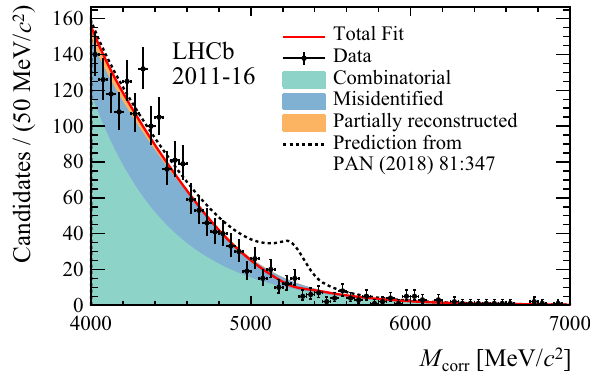
Fig. 4 Correctedmassdistributionoftheselected B + → μ + μ − μ + ν μ candidates with the fit overlaid. Samples with low and high corrected mass uncertainty are fitted as individual samples but are merged in the figure. The fit has components for (green) combinatorial background, (blue)misidentifiedcandidatesand(orange)partiallyreconstructedcan- didates. The signal component is not visible as the fitted signal yield is negative. The best fit is the solid red line while the dashed line shows how the total would have looked like if the signal had the branching fraction predicted in Ref. [11]